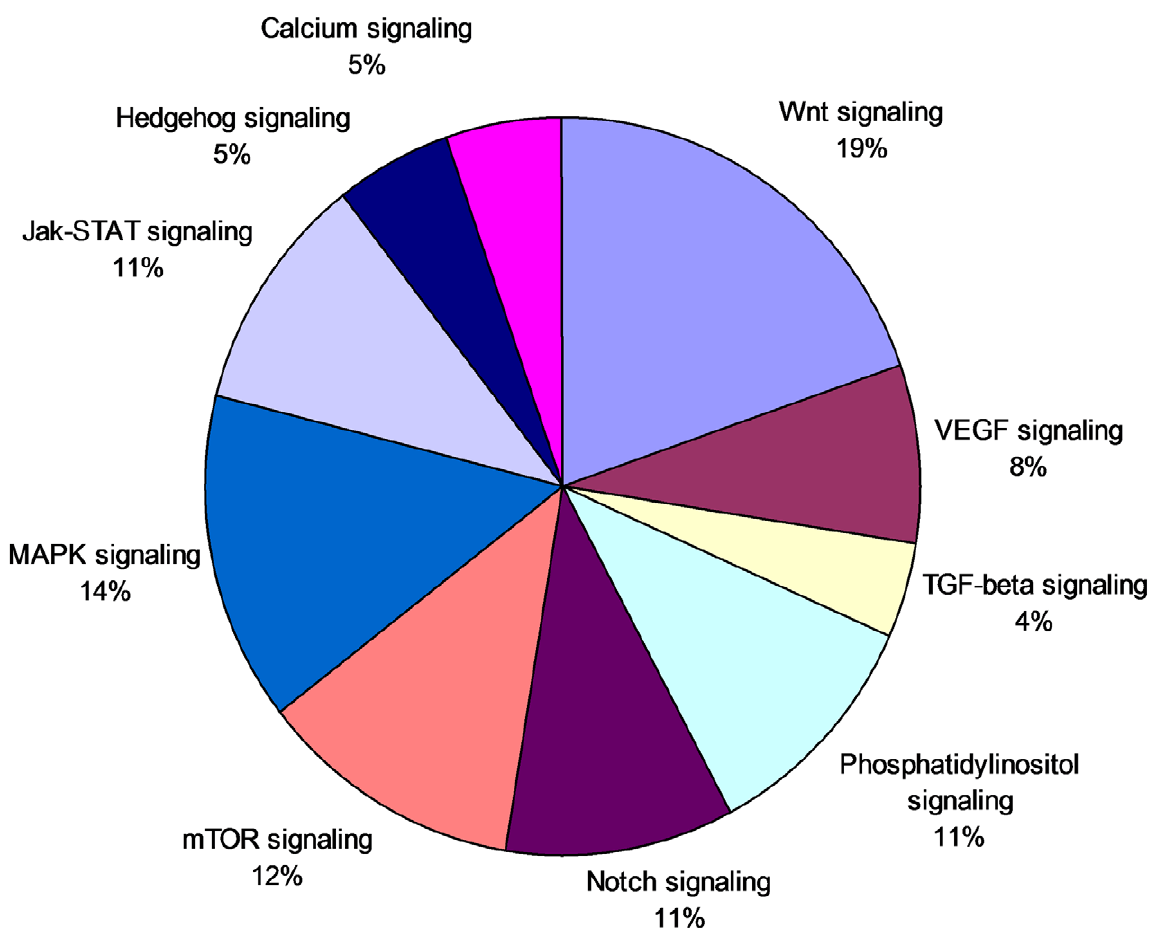
Figure 5. A pathway diagram of JAK-STAT cascades of dengue responsive genes. The KEGG pathway template was used to generate this diagram by mapping the responsive genes (genes responsive in MS strain are in pink and genes responsive in MR strain are in green).